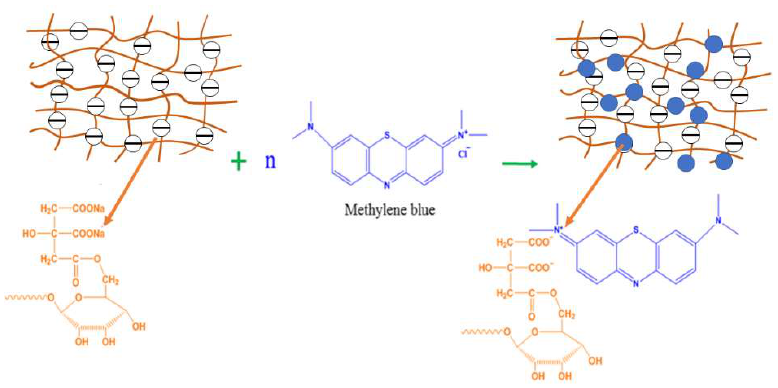
Figure 6. Possible adsorption mechanism for the adsorption of MB on MPPL.